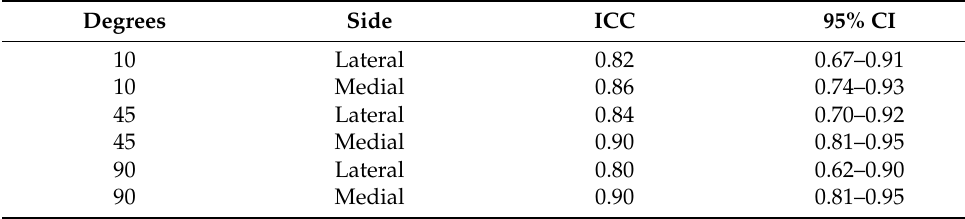
Table 4. Intraclass correlation coefficients for Scenario